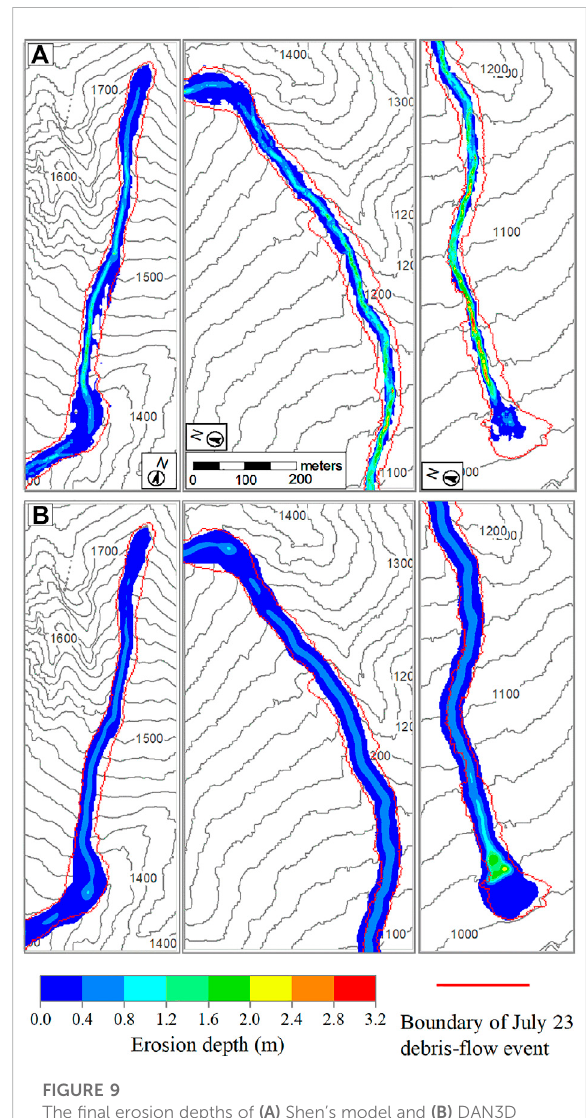
FIGURE 9 The fi nal erosion depths of (A) Shen ’ s model and (B) DAN3D